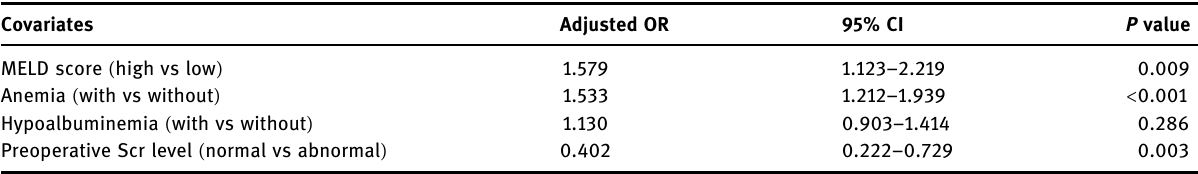
Table 4: Multivariate logistic regression analysis for risk factors of post - OLT AKI Covariates Adjusted OR MELD score ( high vs low